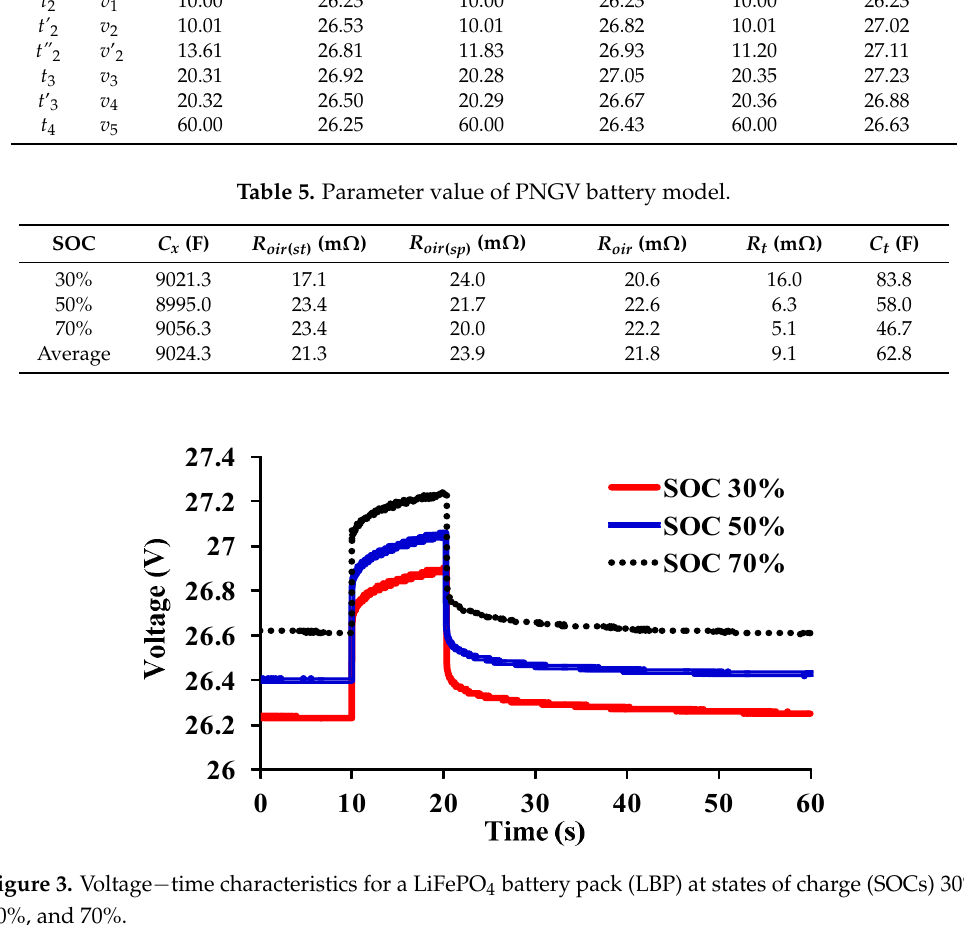
Table 4. Records of voltages and times.